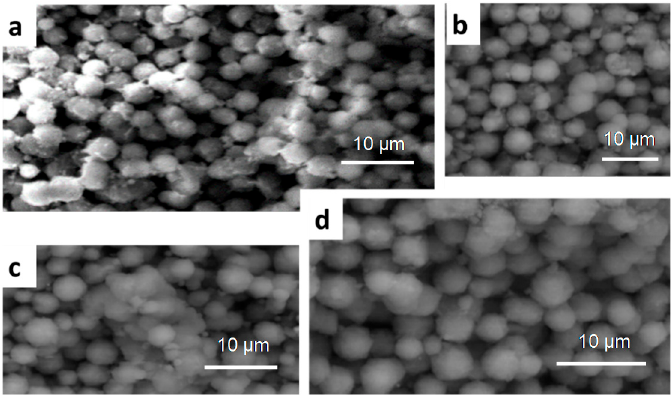
Figure 7. SEM-EDX of raw ( a ), spent ( b ) and regenerated catalyst (non-treated) after 2 cycles ( c ) and 3 cycles ( d ) at 700 °C.